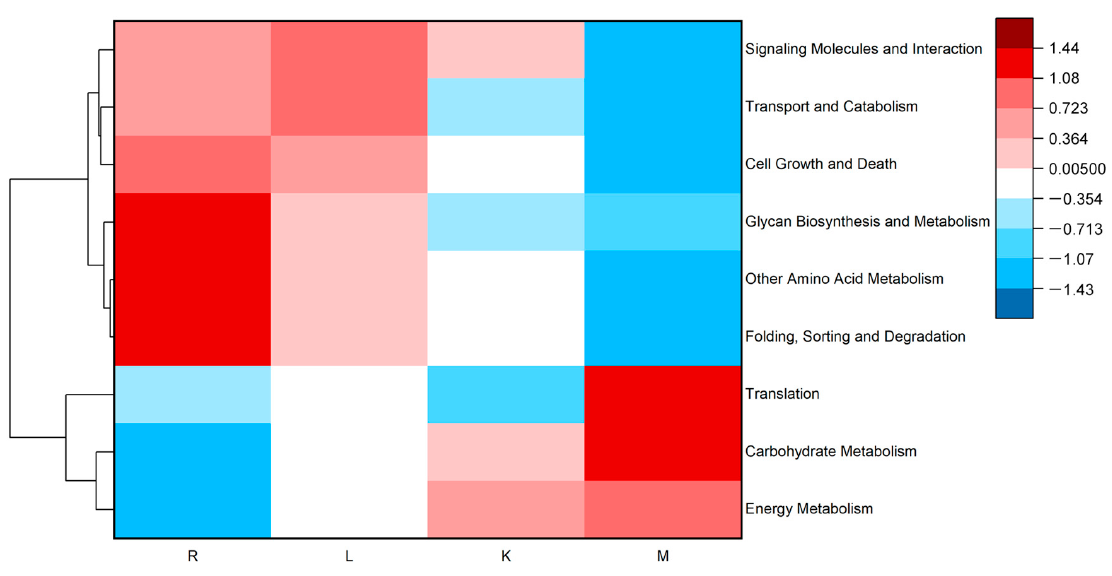
Figure 5. Comparison of differences in abundance between KEGG secondary functions with different vegetation types. Notes: M is alfalfa; R is yellow rose; L is lespedeza; K is sweet wormwood herb.